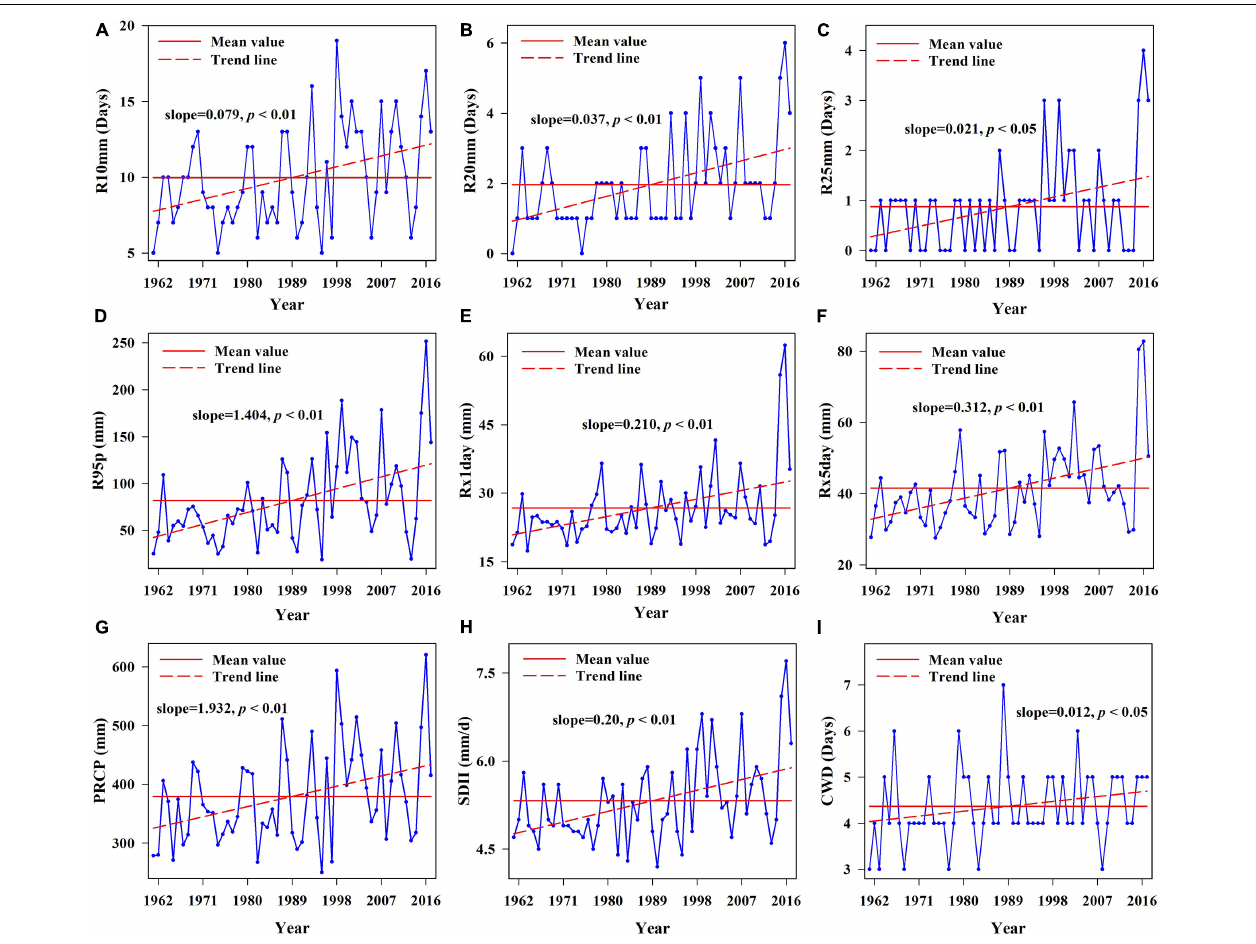
FIGURE 3 | Linear trend charts of annual extreme precipitation indices during 1961–2017. (A) Linear trend chart of light rain days, (B) linear trend chart of moderate rain days, (C) linear trend chart of heavy rain days, (D) linear trend chart of very wet days, (E) linear trend chart of maximum one-day precipitation, (F) linear trend chart of maximum five-day precipitation, (G) linear trend chart of annual total precipitation, (H) linear trend chart of simple precipitation intensity index, and (I) linear trend chart of consecutive wet